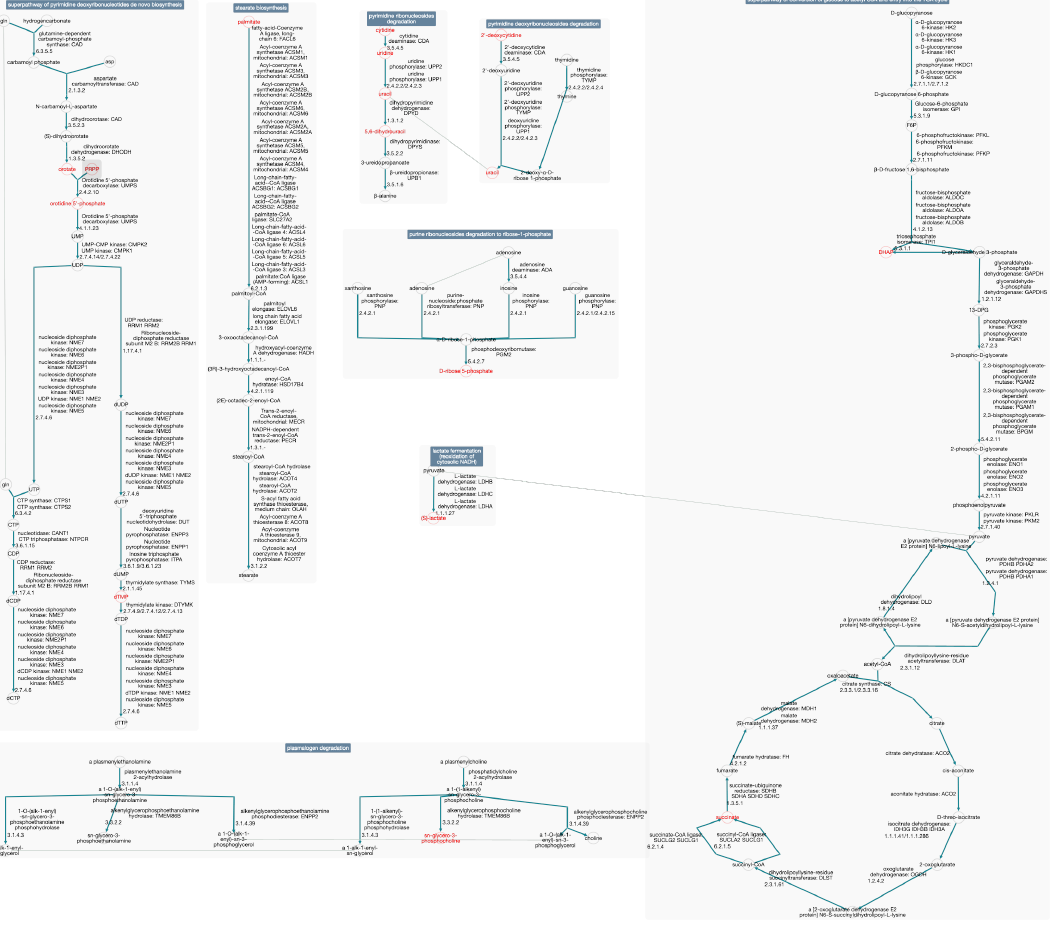
Figure 2. This is a pathway collage showing the pathways in the constant pathway cost solution for the McDonnell data set and highlighting most of the covered compounds. Three covered compounds (NAD+, coenzyme A, guanine) are not shown in the collage because they are considered side compounds of reactions (meaning they are not shared between consecutive reactions in the pathway) and are not drawn by the pathway layout algorithm. Two compounds, glycerone phosphate and 5-phospho-alpha- D -ribose 1-diphosphate are shown on the collage under different names, DHAP and